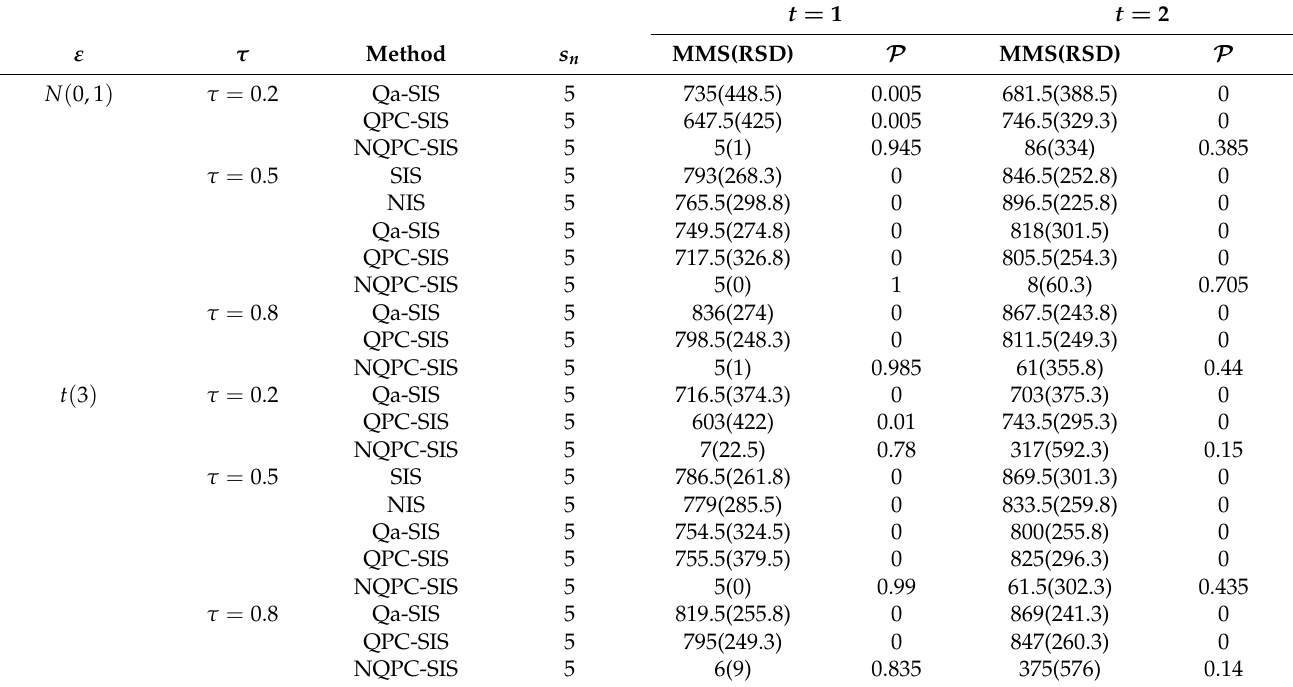
Table 4. Simulation results for Example 4 when n =